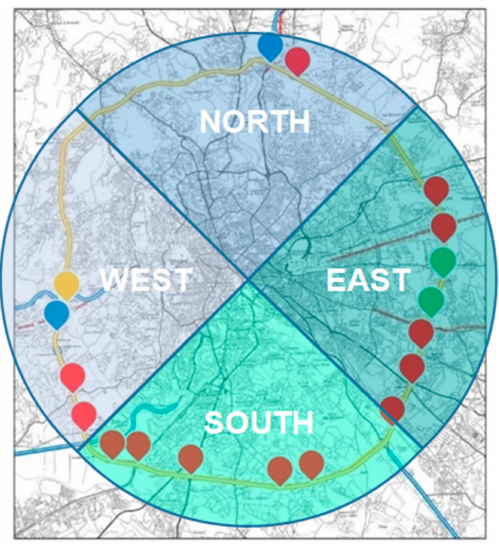
Figure 3. The four wind sectors of the pilot area of